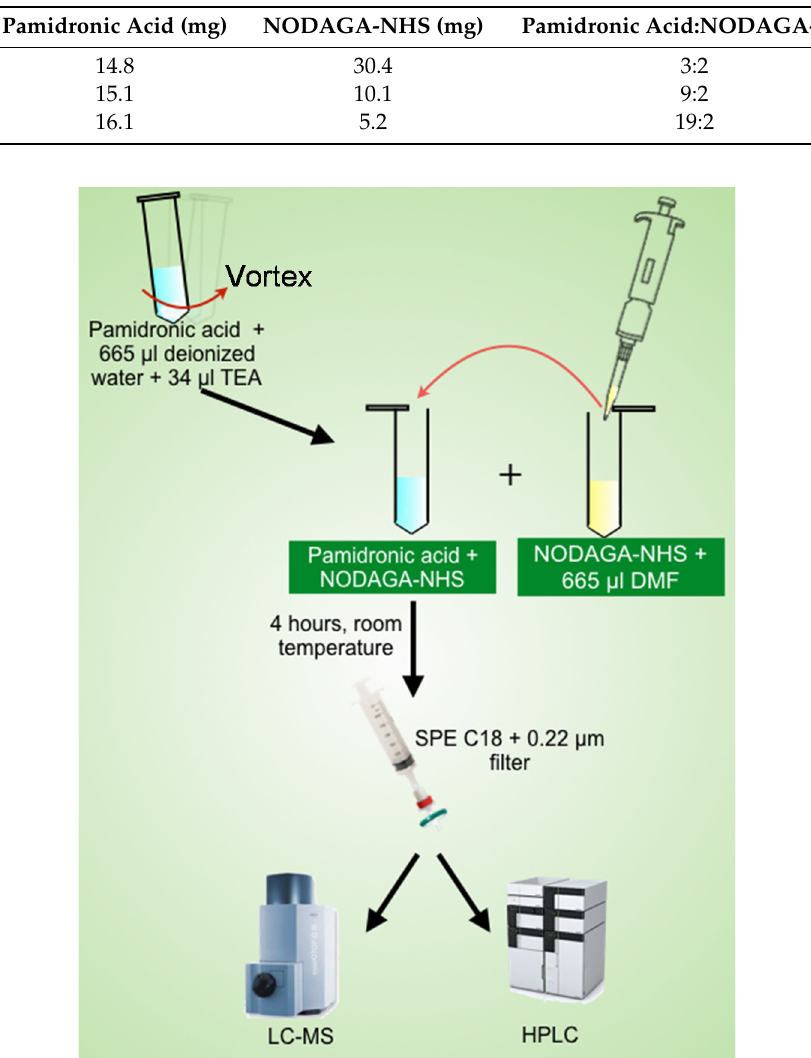
Figure 4. Schematic illustration of the NODPAM preparation process. Table 1. Pamidronic acid and NODAGA ‐ NHS molar ratio.